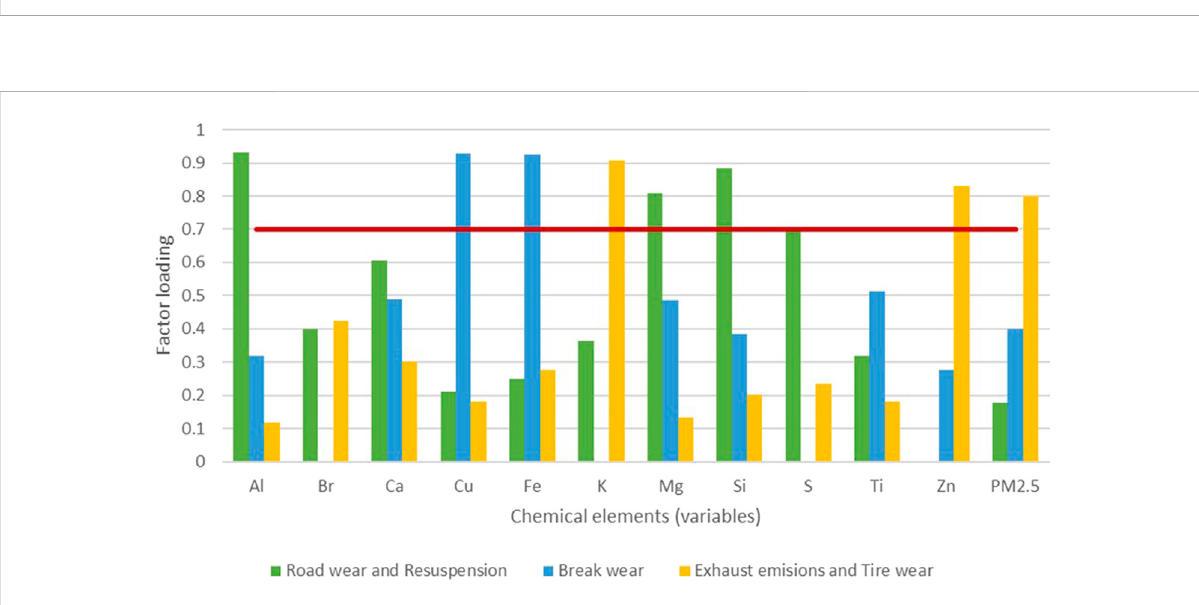
FIGURE 12 Factor loadings of variables (chemical elements and PM) to factors (PM sources) for data matrix PM 2.5 obtained by